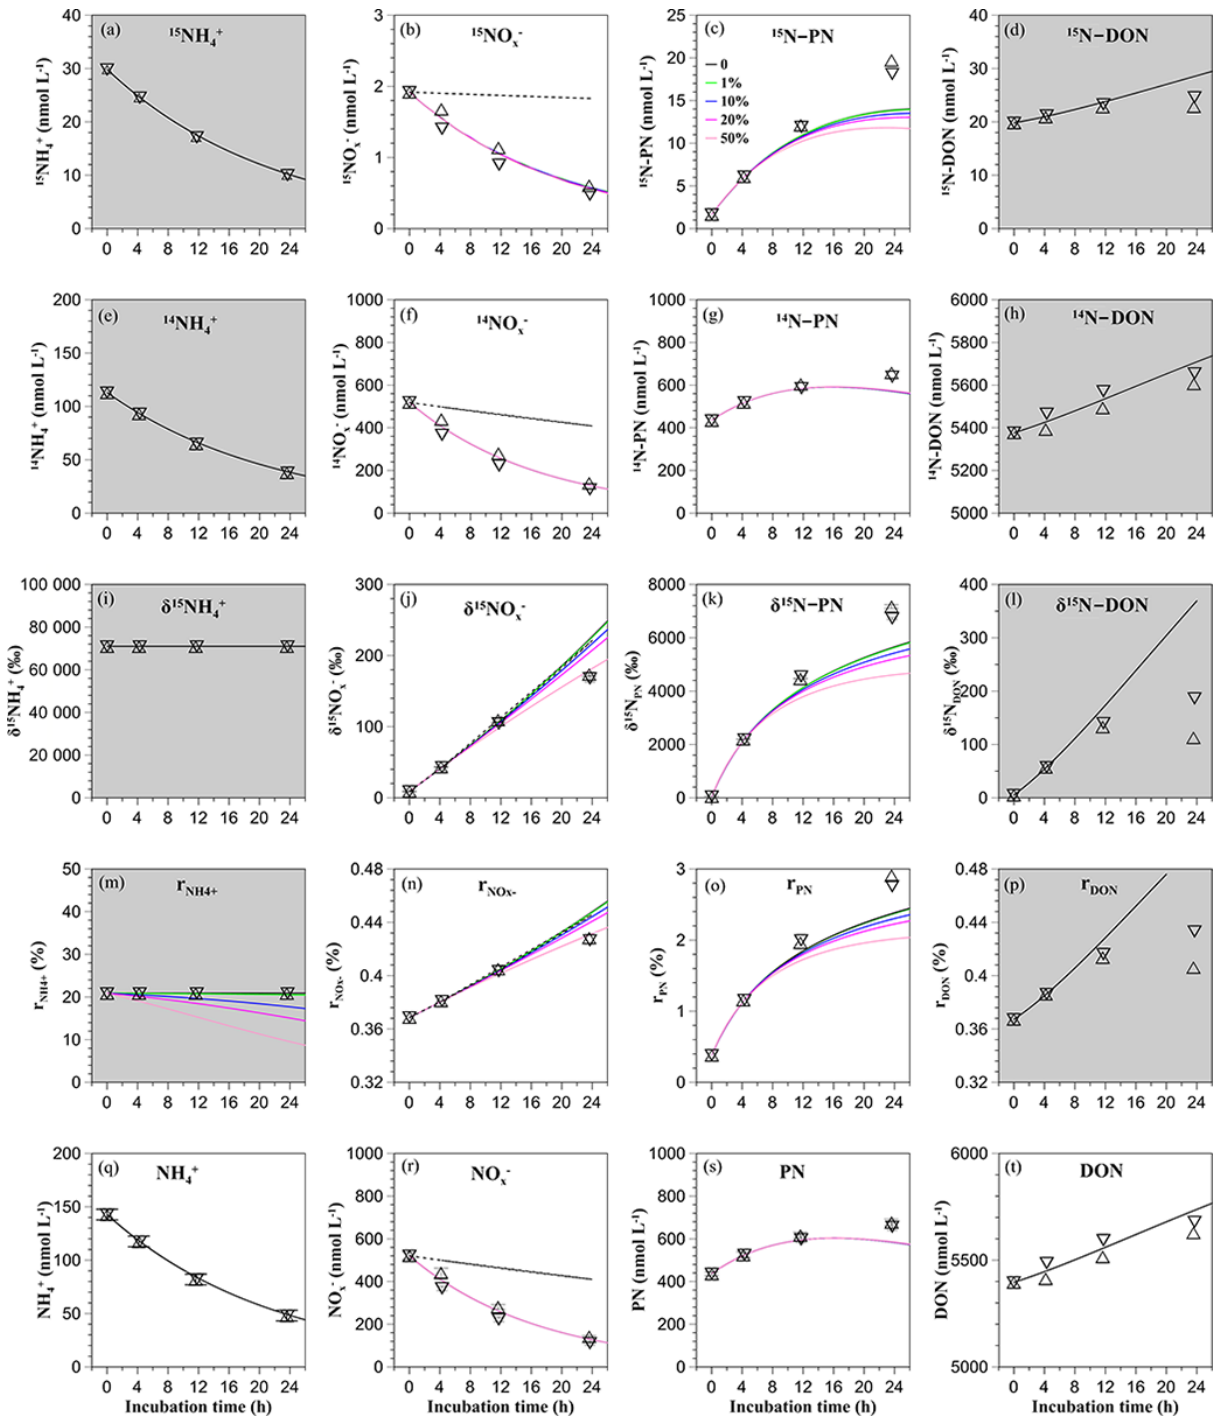
Figure 4. The observed and STELLA-derived values in the low-nutrient case for (a) [ 15 NH + ], (b) [ 15 NO − x ], (c) [ 15 N-PN], (d) [ 15 N-DON], 4 (e) [ 14 NH + ], (f) [ 14 NO − x ], (g) [ 14 N-PN], (h) [ 14 N-DON], (i) r , (j) r , (k) r PN , (l) r DON , (m) δ 15 N-NH + , (n) δ 15 N-NO − x , (o) δ 15 N- NO − x NH + 4 4 4 PN, (p) δ 15 N-DON, (q) [NH + ], (r) [NO − x ], (s) [PN], and (t) [DON]. The black regular and inverse open triangles represent the paralleled 4 observed values; the black, green, blue, magenta, and pink solid lines represent the STELLA model simulations when r decreases 0, 1, NH + 4 10, 20, and 50% in 24h, respectively. The dashed lines in (b) , (f) , (j) , (n) , and (r) were generated from nonlinear least-squares curve fitting by MATLAB following Santoro et al.